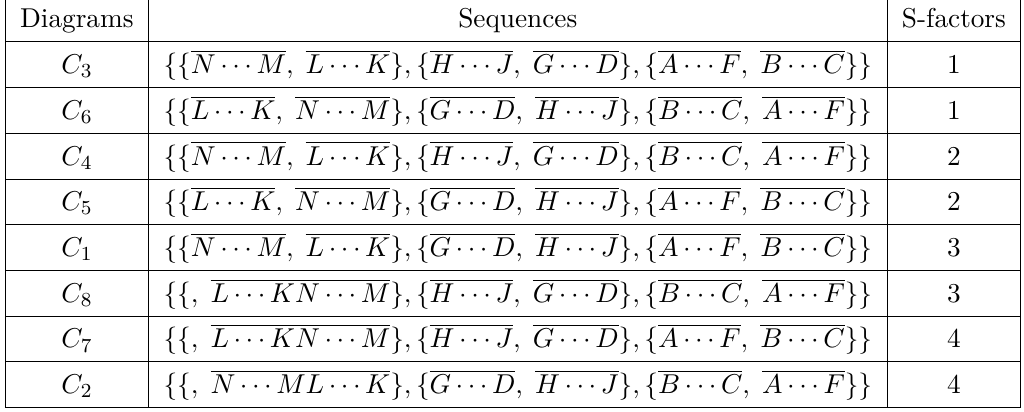
(1 , 1 , k + p, m + l, q + n ) 5